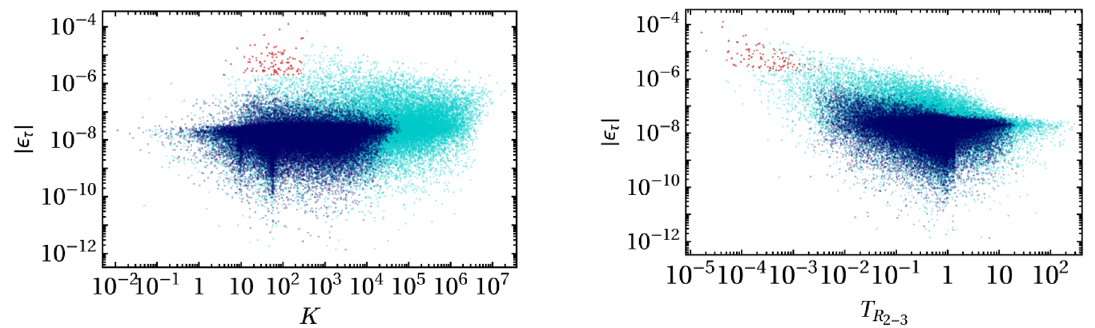
Figure 6 . Scatter plots of j (cid:15) (cid:28) j against K (left) and the ratio de(cid:12)ned in (5.2) (right) for the CP (cid:22)(cid:28) symmetric model assuming M 1 = 10 9 GeV. Light blue and dark blue indicate di(cid:11)erent allowed ranges for parameters in the Casas-Ibarra parametrization. See text for details and also appendix